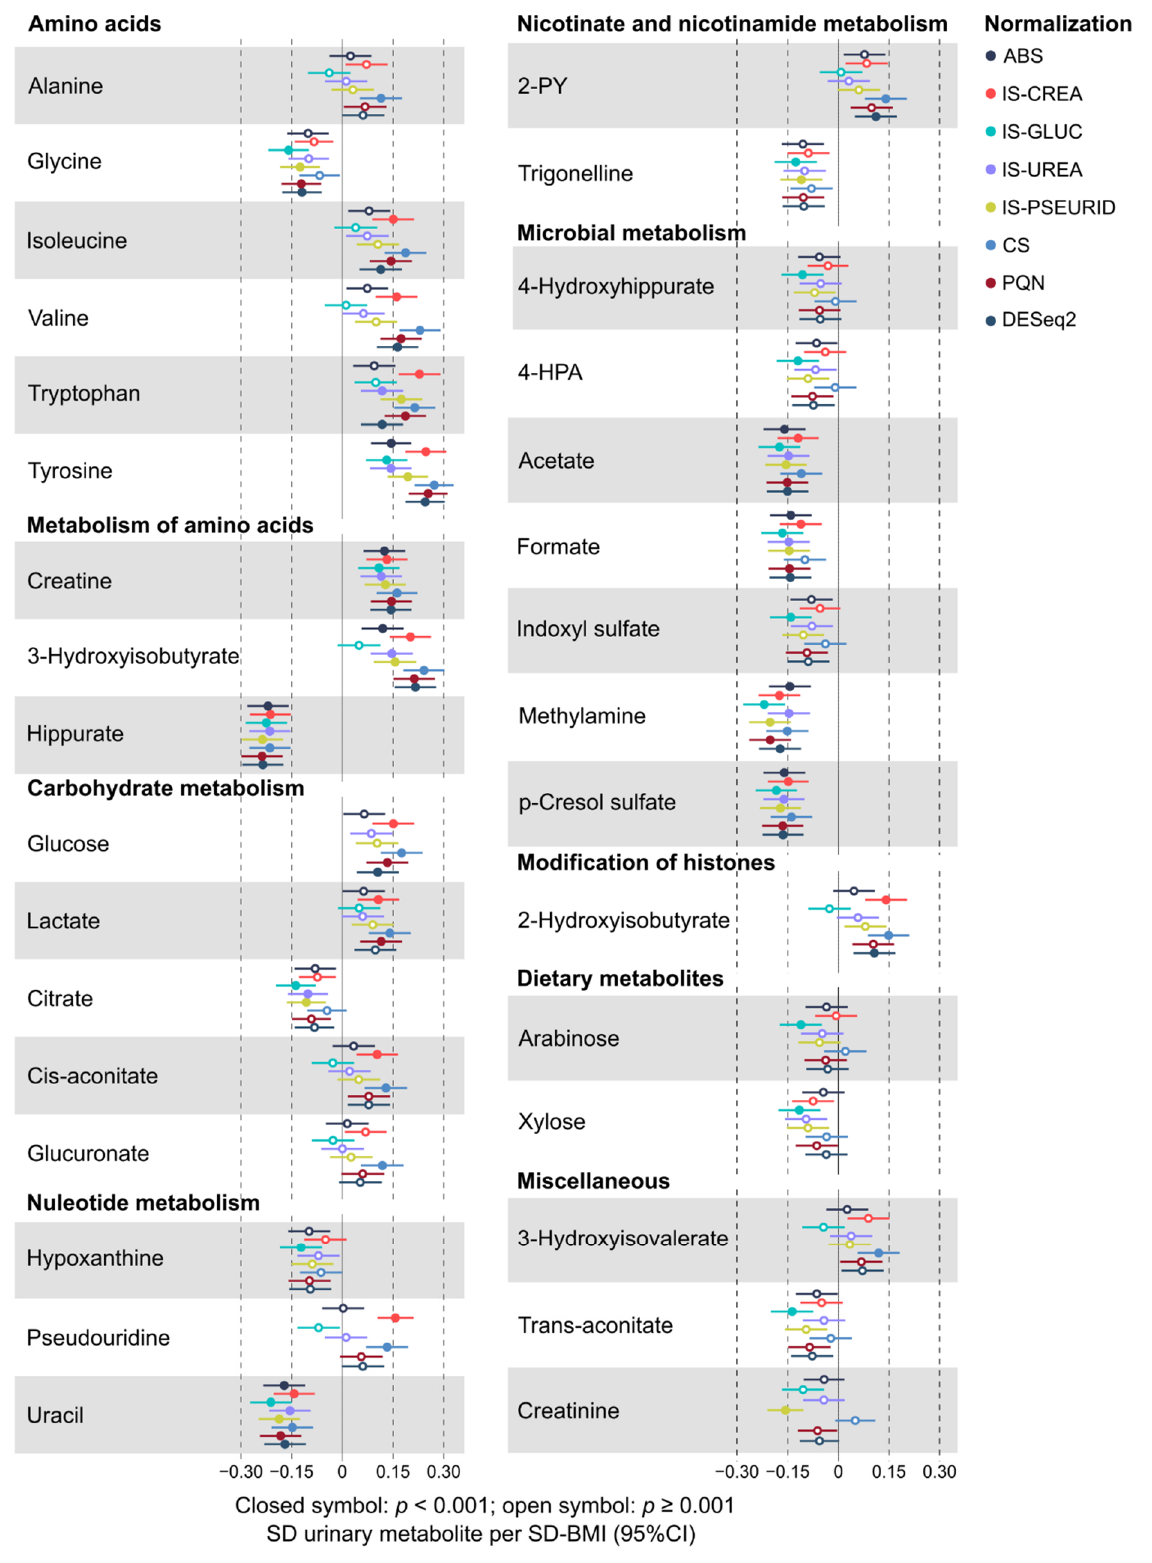
Figure 5. The robust associations ( p < 0.001) of the urinary metabolite concentrations with BMI for the various normalization schemes. See Table 1 for the explanation and basis of the normalization methods. Abbreviations: 2-PY, N1-Methyl-2-pyridone-5-carboxamide; 4-HPA, 4-Hydroxy-phenylacetate.